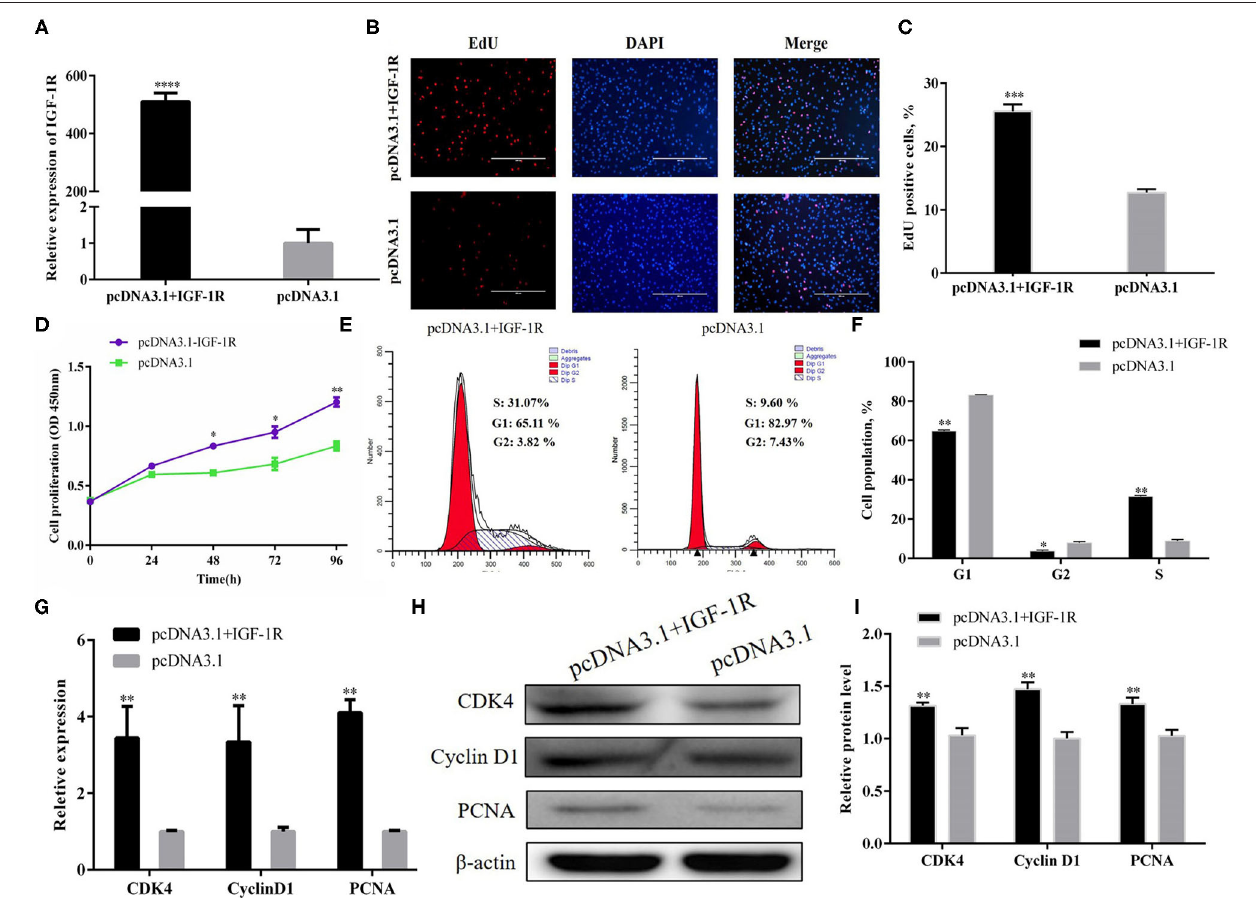
FIGURE 5 | IGF-1R facilitated PSC proliferation. (A) Transfection efficiency of IGF-1R overexpression. (B) EdU staining after the transfection of IGF-1R overexpression in PSCs. (C) Statistical results of EdU staining. (D) CCK-8 assay after the transfection of pcDNA3.1 + IGF-1R into PSCs. (E) Flow cytometry raw data of the cell cycle analysis of PSCs after IGF-1R overexpression. (F) Statistical results of cell cycle analysis. (G) MRNA expression levels of cell cycle marker genes. (H,I) Protein levels of cell cycle marker genes. Results are shown as mean ± SEM, and the data are representative of at least three independent assays. Independent sample t -test was used to analyze the statistical differences between groups (* P < 0.05, ** P < 0.01, *** P < 0.001, and **** P < 0.0001).